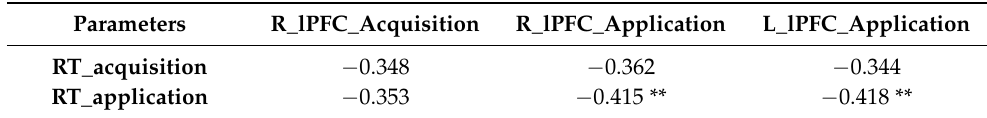
Table 5. Correlation table between WCST reaction time and PFC FC parameters (whole-group